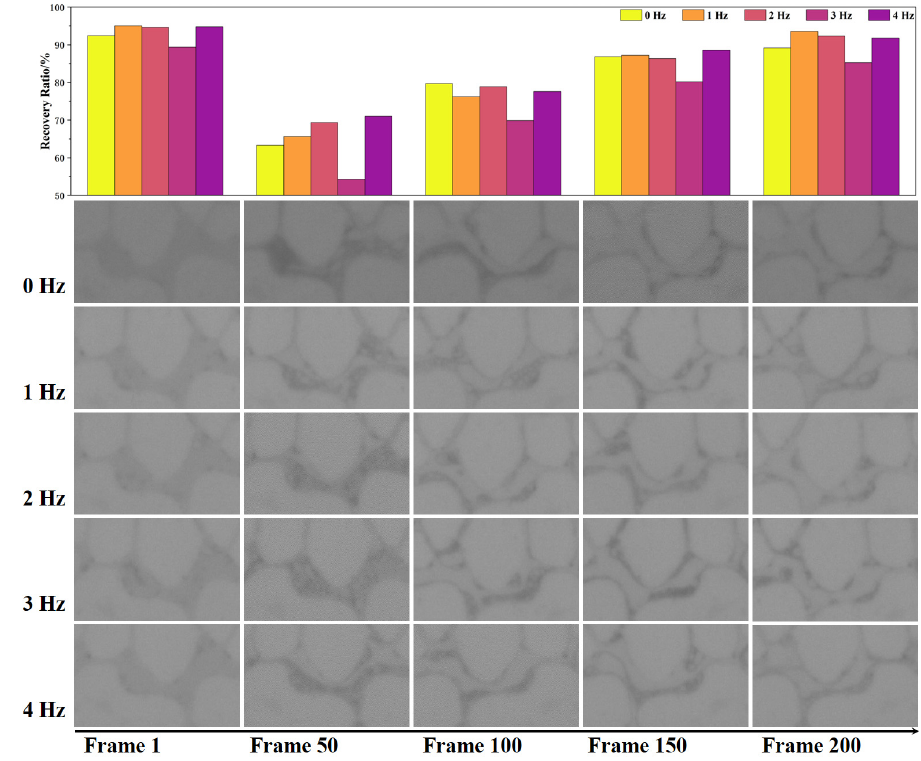
Figure 10. The oil/water distribution images in Block 4 and recovery factor cluster plots when the amplitude is 0.005 mL/min.